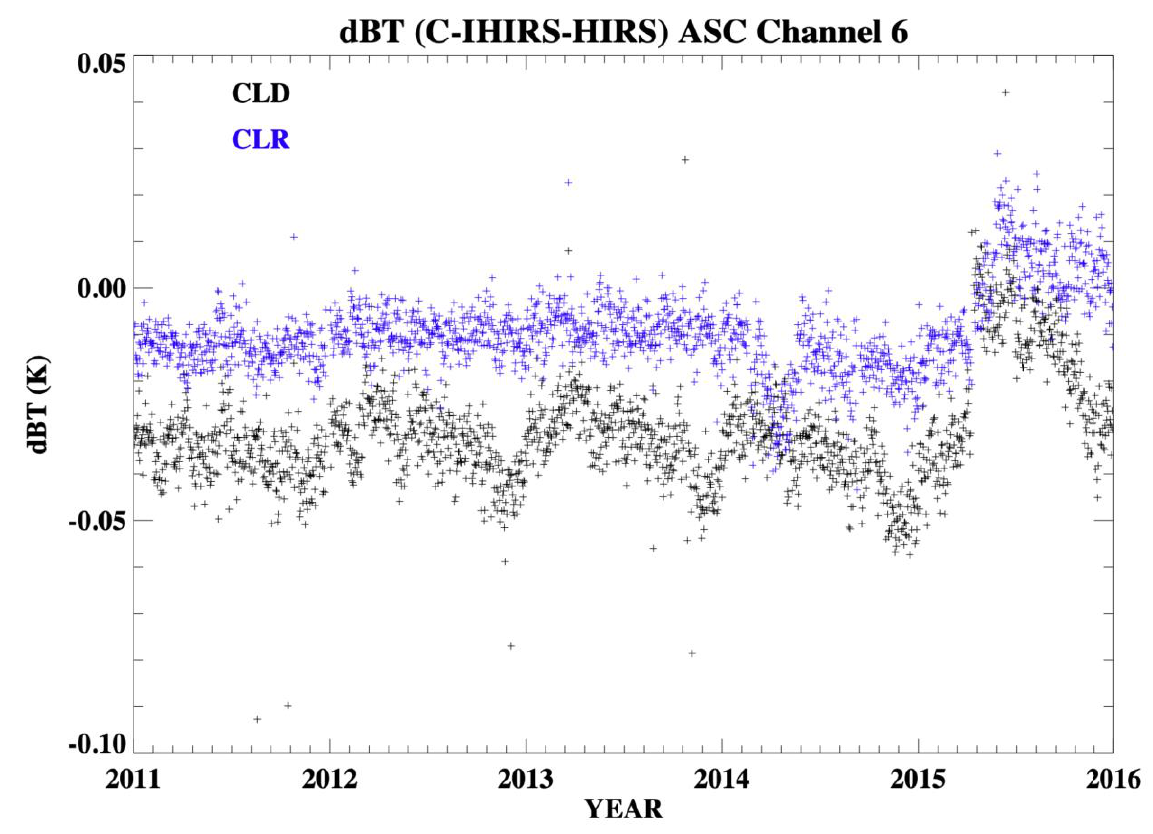
Figure 9. Time series of median difference (C-IHIRS − HIRS) for each day from 2011 to 2015 for channel 6.